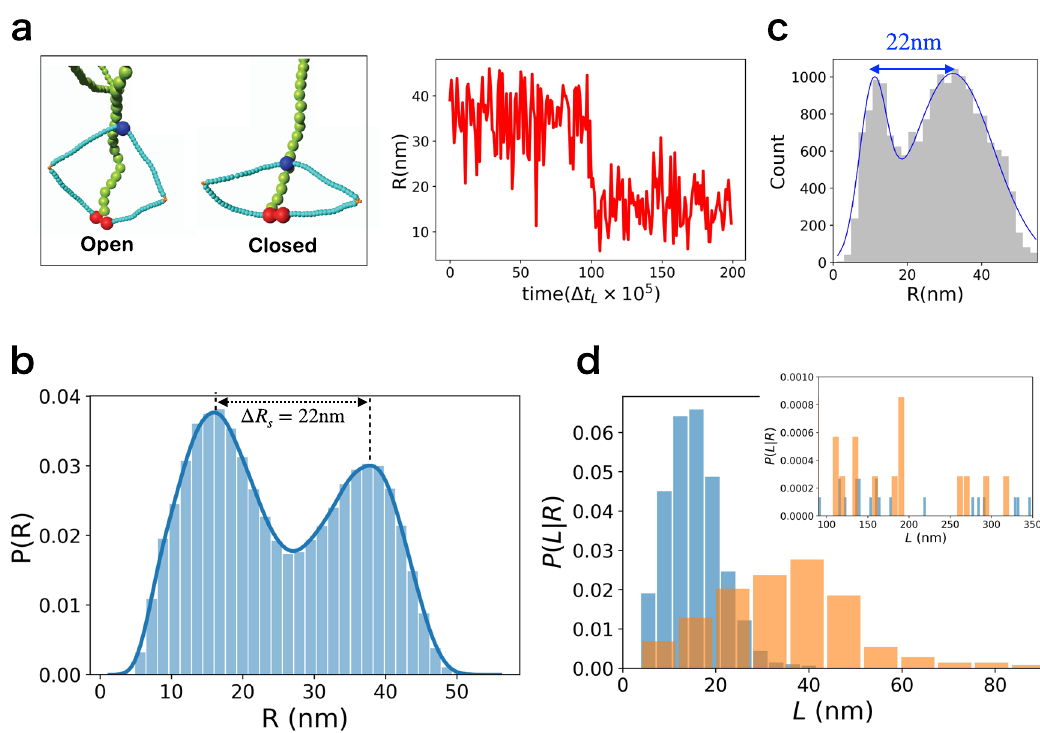
Fig. 5 Simulations for the transition between O → B transition. a Left panel: Representative pictures from the simulation. Red, blue, light blue, orange, and green spheres are the heads, hinge, CC, elbows, and DNA, respectively. Right panel: The trajectory for the change in head-hinge distance ( R ). Δ t L is the time step of simulation (SI Sec. I). b Predicted distributions, P ( R )s, of the head-hinge distance during one catalytic cycle of the motor. The peak positions for open state and closed state ( R 1 = 38 nm and R 2 = 16 nm, respectively). The large width and the overlap between the two distributions implies a great deal of conformational heterogeneity that contributes also to broad step size distribution. c The distribution for R taken (digitized) from Ryu et al. 19 . The agreement between the simulations and experiments is remarkable, especially considering that the model has no fi tting parameters. d Histograms in orange are the distribution of L in the open shape, and the blue histograms are the distribution in the closed shape. The inset shows the distributions for L > 90 nm. We performed 50 simulations from which 100,000 sample points were used to create the histograms. Data plotted in a – d are provided as a Source Data fi